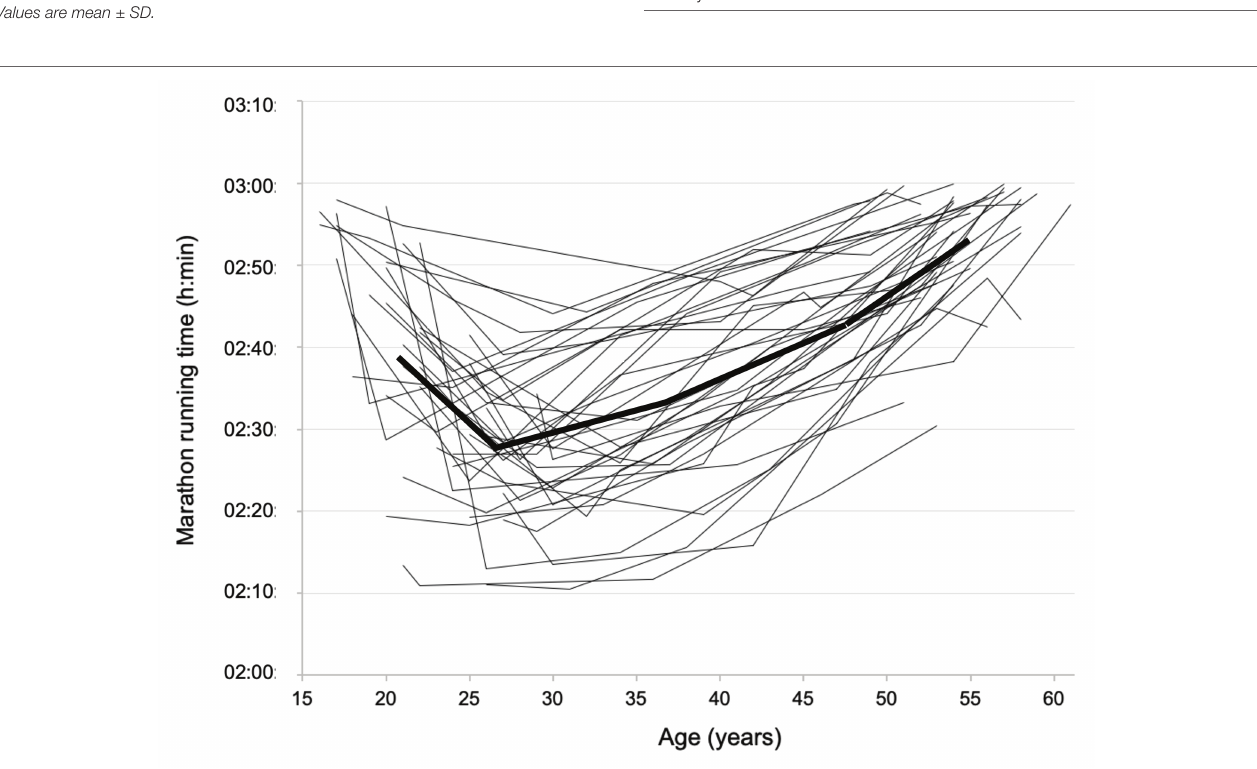
FIGURE 1 | Marathon time performances of the 5DS3 runners ( n = 40) plotted against increasing age during the five consecutive calendar decades (from 1970s to 2010s). The bold line represents the mean trace of all